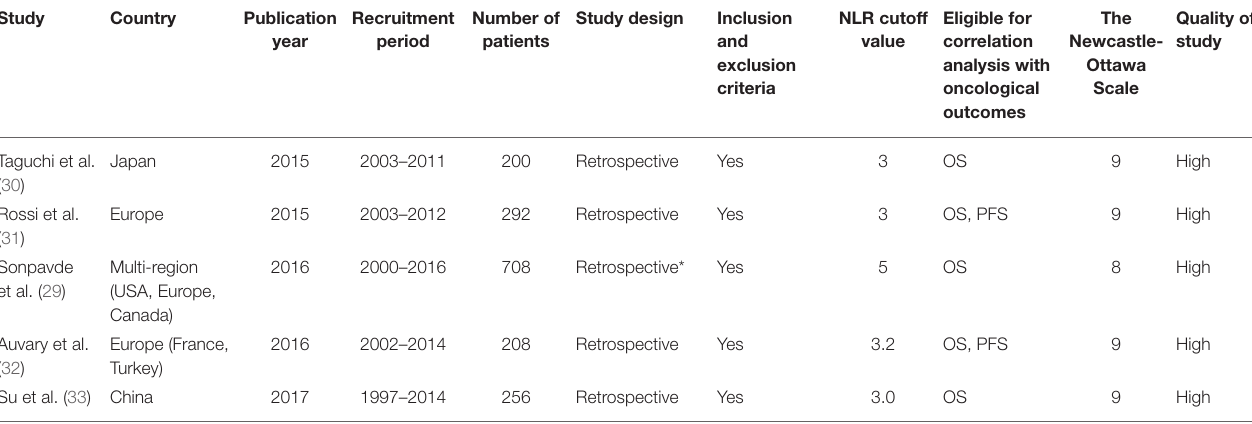
TABLE 3 | Characteristics of studies eligible for chemotherapy analysis.